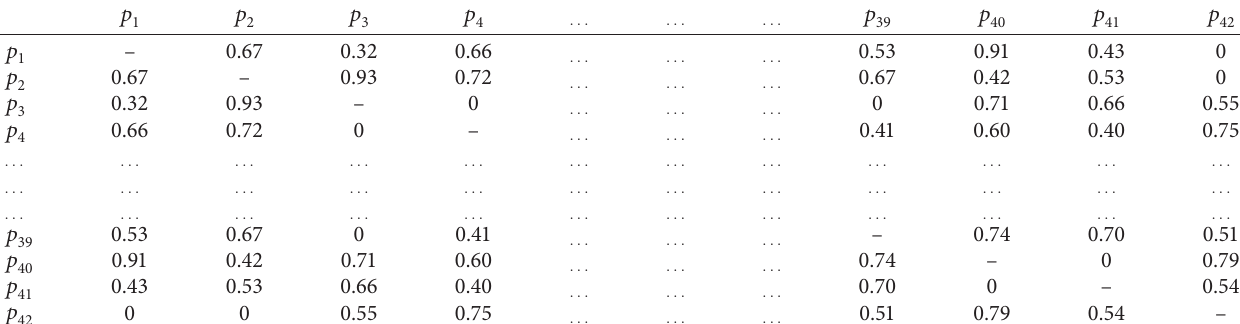
Table 10: Overall values of knowledge collaboration performance among candidates.